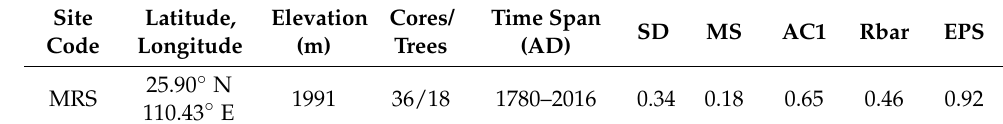
Table 1. Site information and tree-ring chronology statistics.